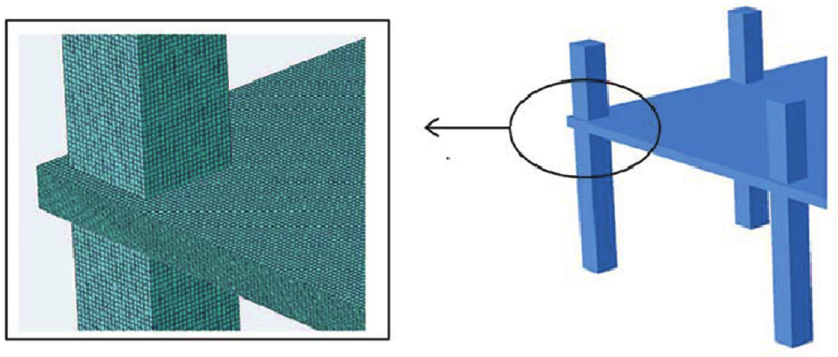
Figure 3: Mesh detailing around one of the corner columns in the full-scale FE models.